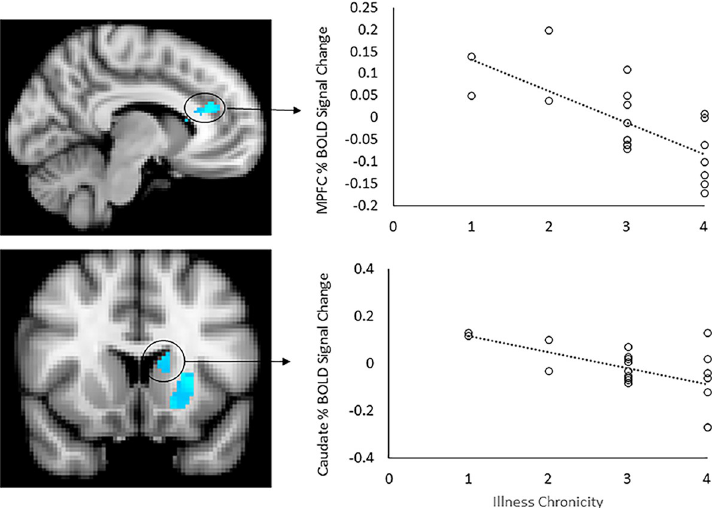
Fig 4. Activation as a function of illness course. Patterns of activation were compared based on the course of illness as collapsed into 4 levels (higher levels indicate more stable illness course). With increased duration of illness, there was decreased activation in the medial prefrontal cortex, bilateral caudate and left putamen and accumbens in the contrast of whole body images > scrambled images (left panel). Slices are shown at X = -8 (top left) and Y = 14 (bottom left). Scatterplots represent mean percent BOLD signal change extracted from significant functional clusters in the mPFC (top right) and left caudate (bottom right), plotted against illness course scores.